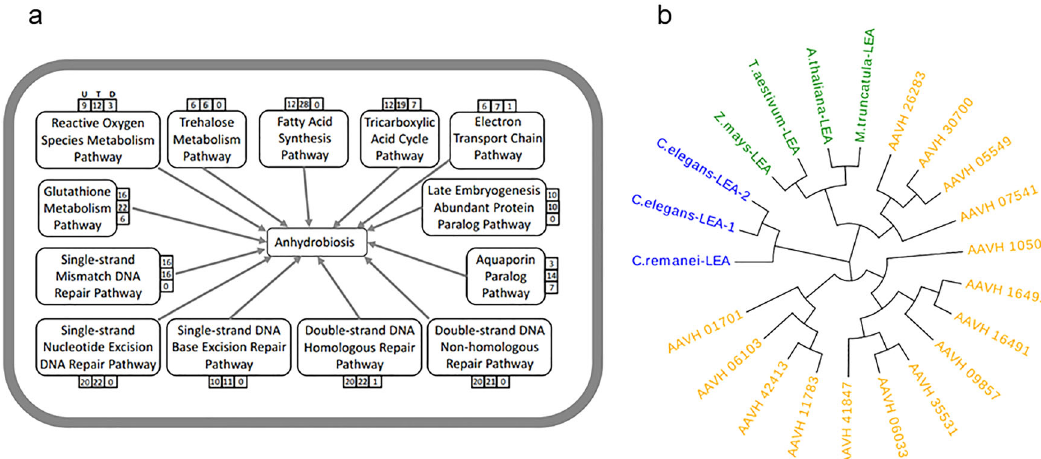
Fig. 3 Essential pathways and duplication of LEA proteins involved in A. avenae anhydrobiosis. a Schematic of pathways involved in A. avenae anhydrobiosis. U: upregulated gene number, D: downregulated gene number, T: total number of DGE genes. b Phylogenetic tree of group 3 LEA proteins in A. avenae , C. elegans , and A. thaliana